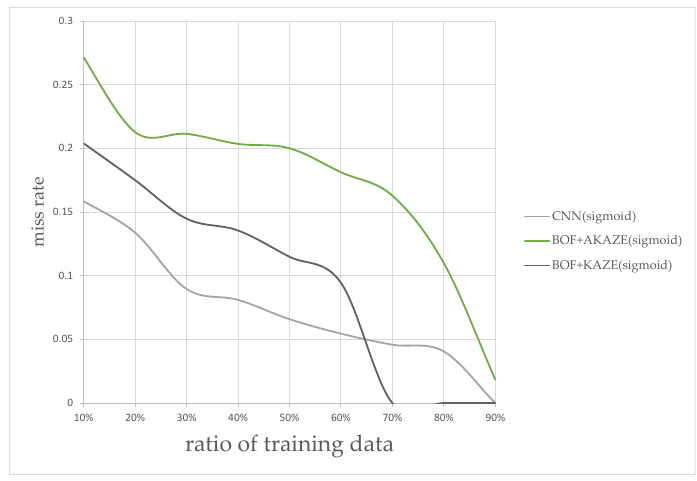
Figure 20. Classification miss rates vs. ratio of training data for sub-optimal images.